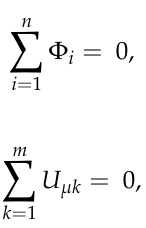
Figure 9. Meshed AFSPM linear structure.